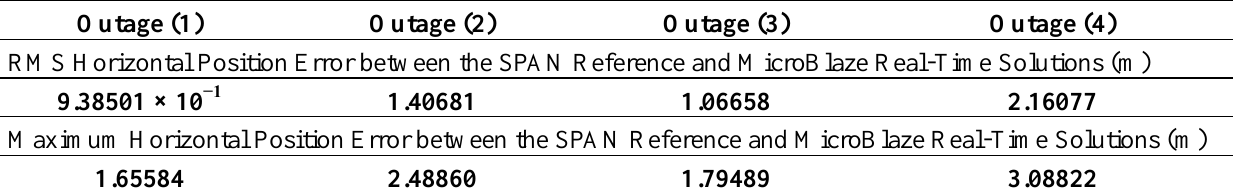
Table 5. RMS and Maximum Horizontal Position Error for the Four 60 seconds Outages Introduced in Mobile Robot Trajectory (2).